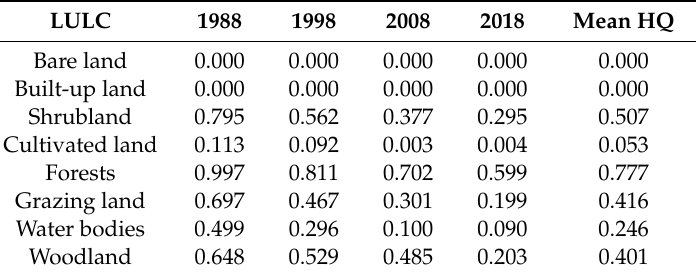
Table 11. Habitat quality trend in each LULC.